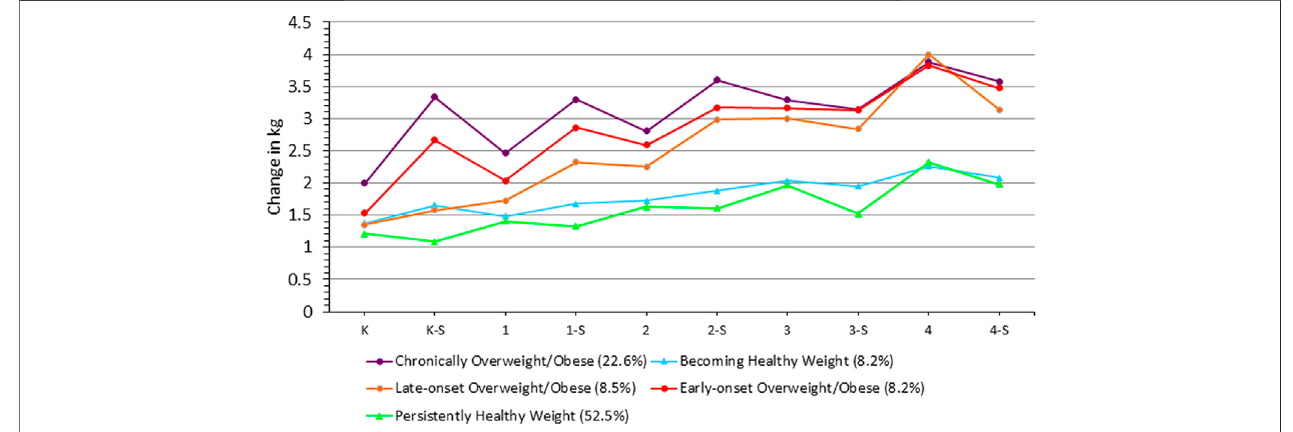
FIGURE4| Seasonalvariabilityinweightgainacrosstrajectorygroups (meansadjustedforage(months),season,sex,andrace/ethnicity).K:Kindergarten School Year;K-S:KindergartenSummer;1:1stGradeSchoolYear;1-S:1stGradeSummer;2:2ndGradeSchoolYear;2-S:2ndGradeSummer;3:3rdGradeSchoolYear;3- S: 3rd Grade Summer; 4: 4th Grade School Year; 4-S: 4th Grade